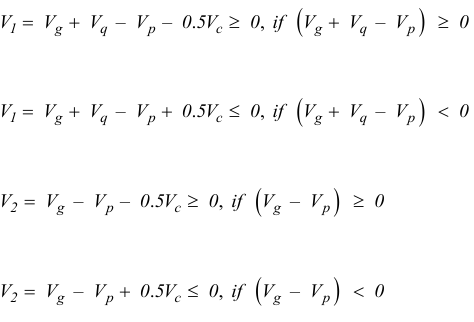
θ : inclination angle of the compression diagonals (struts) regarding the longitudinal axis of the girder (without correction, since the parcel tan θ makes de adjustment in the inclination for fatigue). This angle is 45 degrees for Truss Model I and might vary between 30 to 45 degrees for Truss Model II. In this paper, Model II with a 30-degree angle is considered.